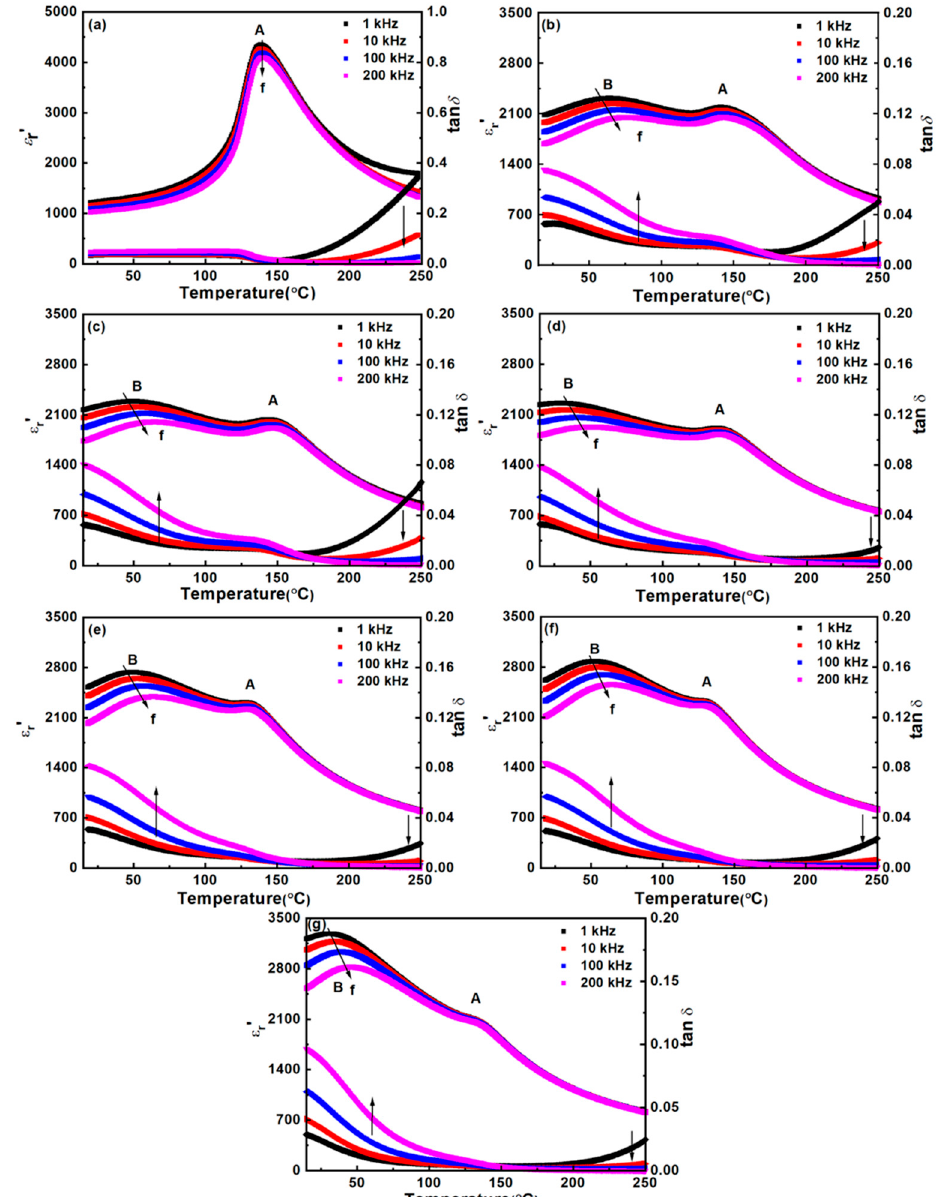
Figure 5. Temperature-dependent permittivity ( ε r ′ ) and the dielectric loss (tan δ ) of the BT-NBT-YM samples at different frequencies. ( a ) BT-NBT, ( b ) x = 0, ( c ) x = 0.005, ( d ) x = 0.01, ( e ) x = 0.015, ( f ) x = 0.02, and ( g ) x = 0.025; A, B indicates the different peaks of ε r ′ – T. f : frequency.